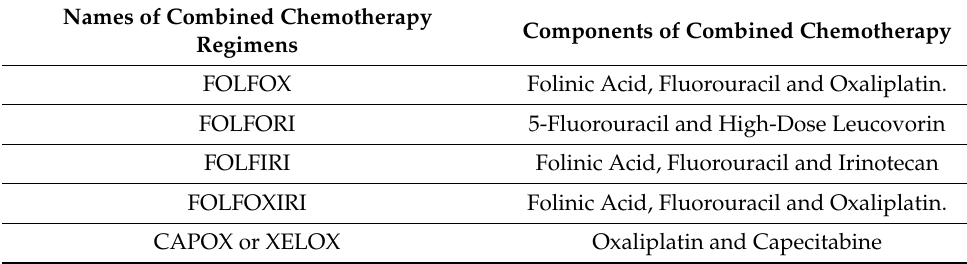
Table 1. Combined Chemotherapy